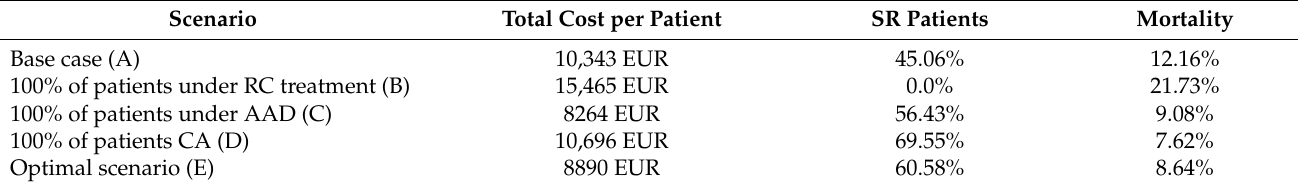
Table 3. Key values of hypothetical situations after 5 years: RC treatment, AAD and